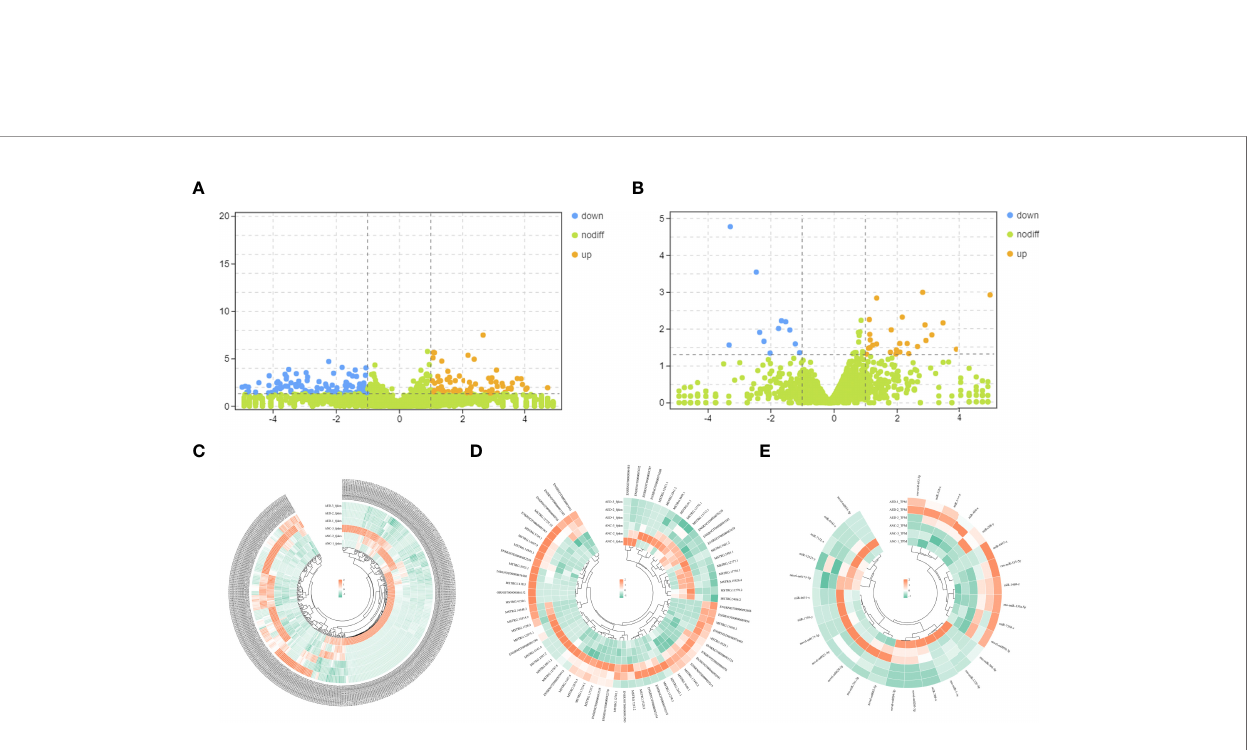
FIGURE 3 | (A) Volcano plots of differentially expressed mRNAs. The abscissa represents the log of the multiple of the difference between the two groups, and the ordinate represents the negative Log10 value of the FDR of the difference between the two groups. (B) Volcano plots of differentially expressed lncRNAs. The abscissa represents the log of the multiple of the difference between the two groups, and the ordinate represents the negative Log10 value of the FDR of the difference between the two groups. (C – E) Heatmaps demonstrate the distribution of differentially expressed lncRNAs, miRNAs, and